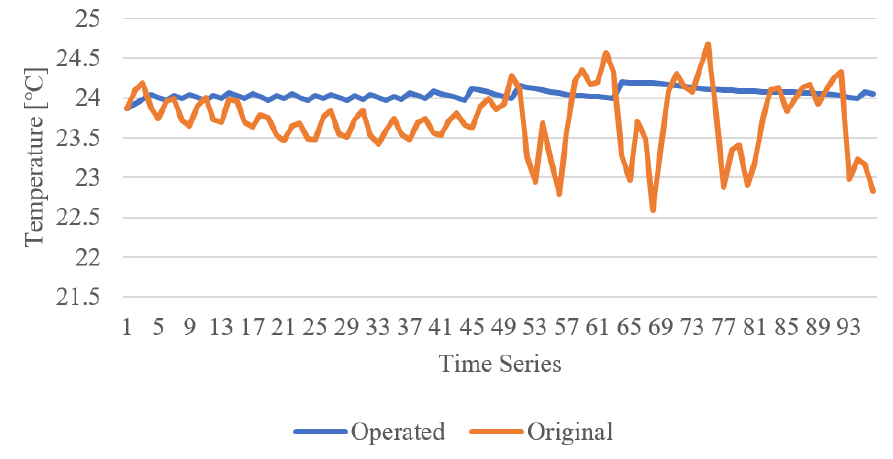
Figure 19. Temperature data comparison of experimental result and original user data.